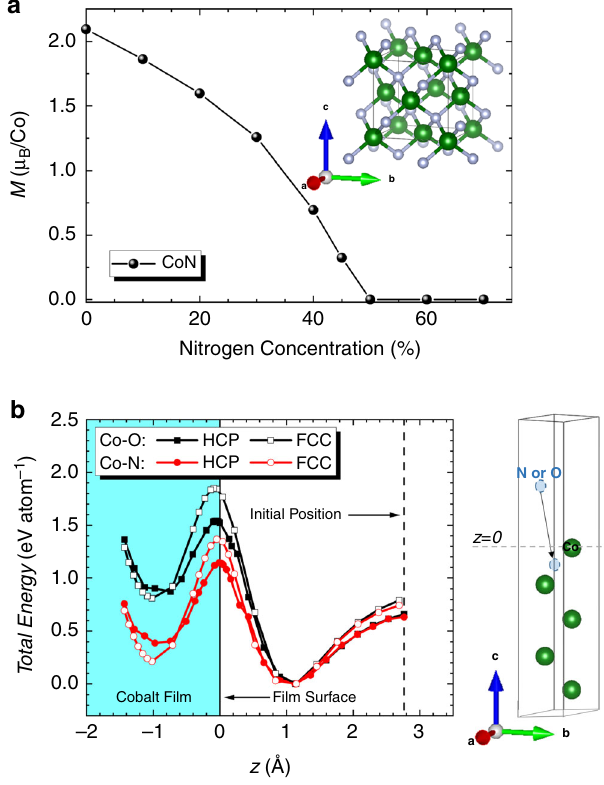
Fig. 5 Ab initio calculations: magnetism in the Co-N system and Co-O vs. Co-N formation energy. a Variation of magnetic moment in Bohr magneton, μ B , per Co atom as a function of increasing the N percentage in the CoN unit cell, shown in the inset, calculated within Virtual Crystal Approximation (VCA). b Calculated total energy per atom, normalized to the minimum energy value, as a function of the displacement between the reference Co outermost surface atom and the inserted O or N atom. Both HCP (0001) and FCC (111) surfaces are considered represented by fi lled and open symbols, respectively. The black squares (red circles) correspond to the O (N) energetic path, respectively. The fi ve-monolayer- thick Co slab is shown in the right panel, where the dashed line indicates the reference z position, which is the outermost Co surface